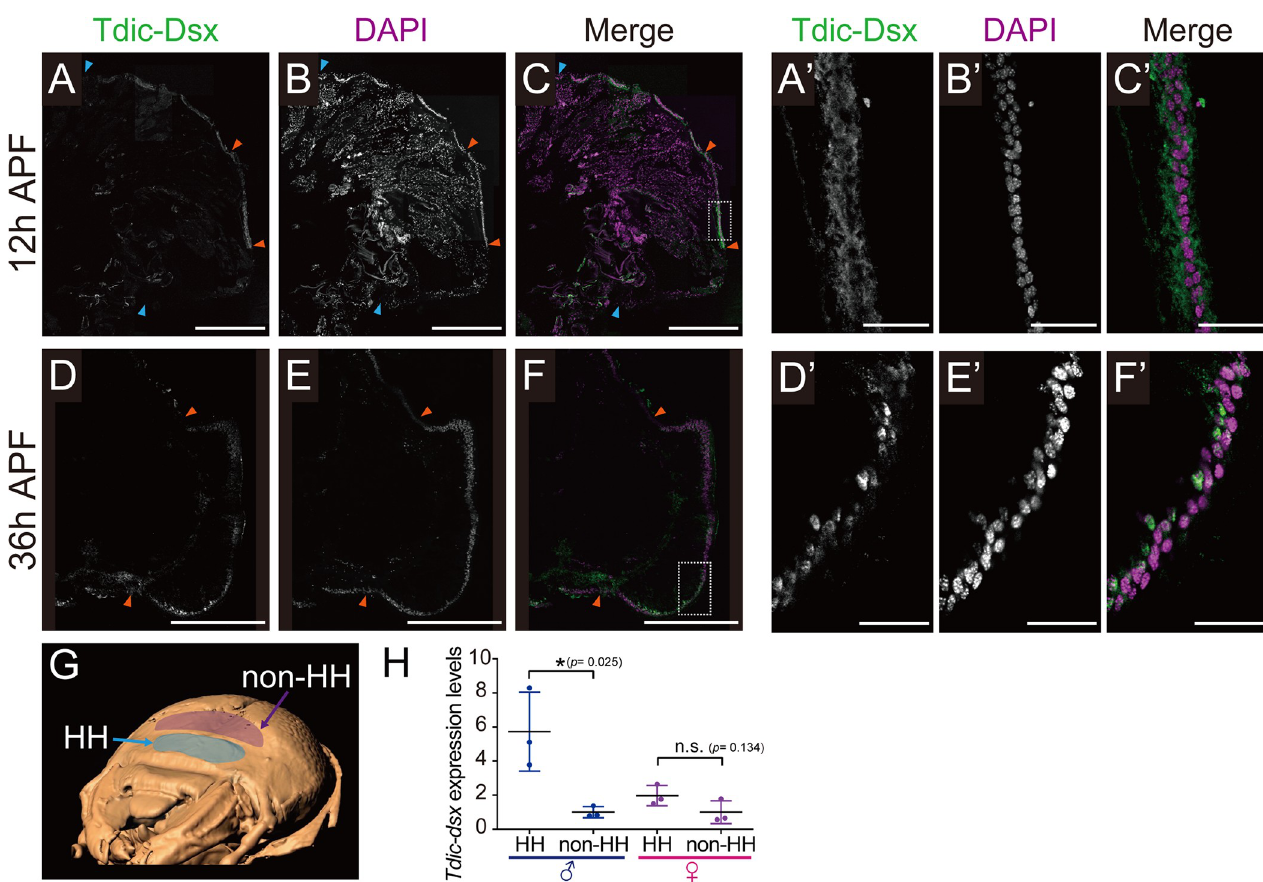
Fig 5. Spatial and temporal expression of Tdic-Dsx protein in the head horn primordium during larval-pupal development. (A-F) The head epidermis including the head horn primordium was stained with DAPI (magenta) to label nuclei and with anti-Tdic-Dsx antibody (green) to label Tdic-Dsx protein. Tdic-Dsx protein showed higher expression in the head primordial epidermis than in the surrounding head epidermis. Between Orange-Orange arrowheads is the head horn primordium. Between Orange-Blue arrowheads is the surrounding head epidermis. (A-C) Tdic-Dsx expression pattern in 12 h APF, Scale bars are 500 μ m. (A’-C’) A higher magnification of the head horn primordium, respectively. Tdic-Dsx protein localization was cytoplasmic. Scale bars are 50 μ m. (D-F) Tdic-Dsx expression pattern in 36 h APF, Scale bars are 500 μ m. (D’-F’) A higher magnification of the head horn primordium, respectively. Tdic-Dsx protein localization were nuclei. Scale bars are 50 μ m. (G) The epidermal regions used for qRT-PCR. The 3D volume image was reconstructed from sequential micro CT images. Blue, head horn primordium (HH); Purple, the head epidermis (non-HH). (H) The relative Tdic-dsx expression level in head horn primordia and head epidermis at 36 h APF in both sexes. Asterisks denote significance: n.s., p > 0.05; � , p < 0.05. HH, head horn primordium epidermis; non-HH, the head